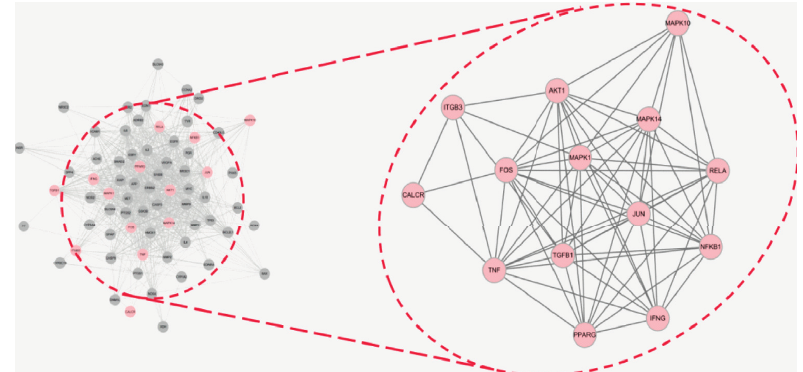
Figure 4: The key core targets of Salvia miltiorrhiza in the treatment of traumatic bone